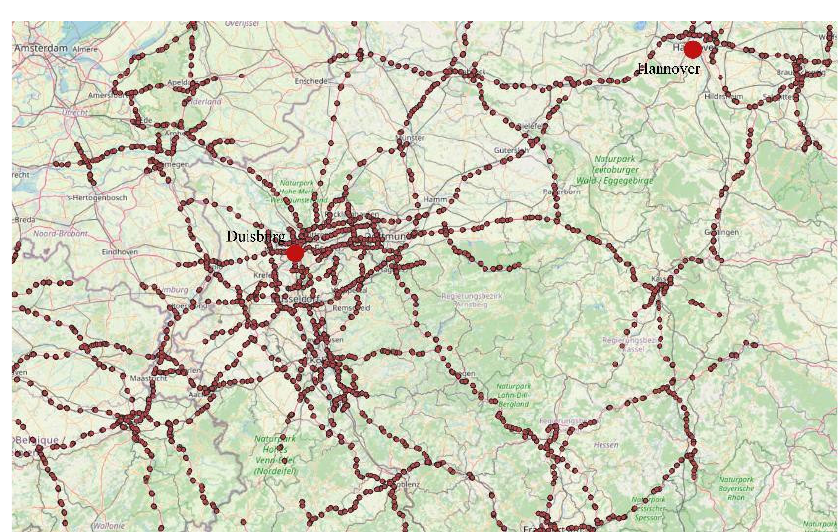
Figure 7. Locations of the highway junctions.